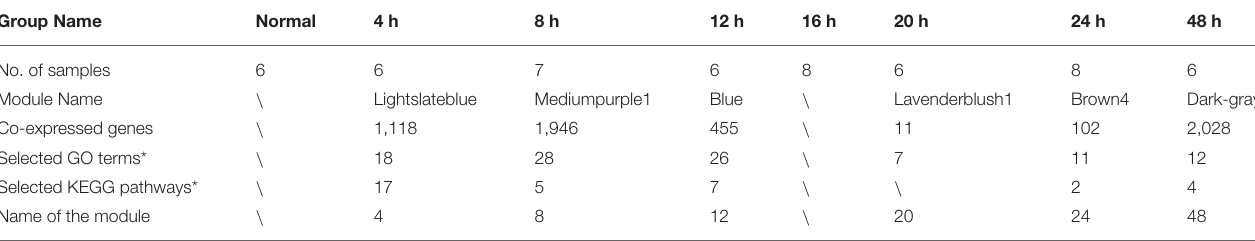
TABLE 1 | The number of samples, genes, selected GO terms, and KEGG pathways associated with the selected gene co-expression module in each